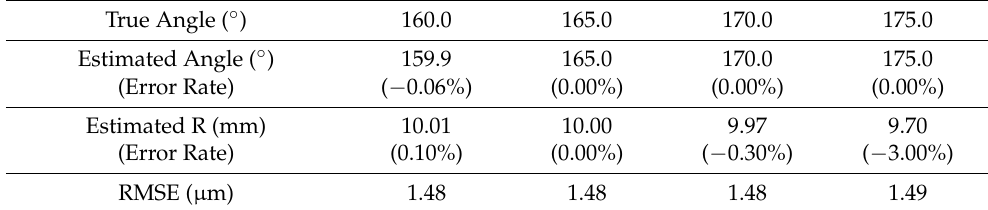
Figure 5. Simulated data points with an arc radius of 10 mm and angle of 170 ◦ . The mean and standard deviation of the Gaussian noise are 0 and 0.001 mm, respectively. The height and length of the wave noise are 0.003 and 0.1 mm, respectively. Table 1. Estimated angles and radii for different angles with an arc radius of 10 mm.